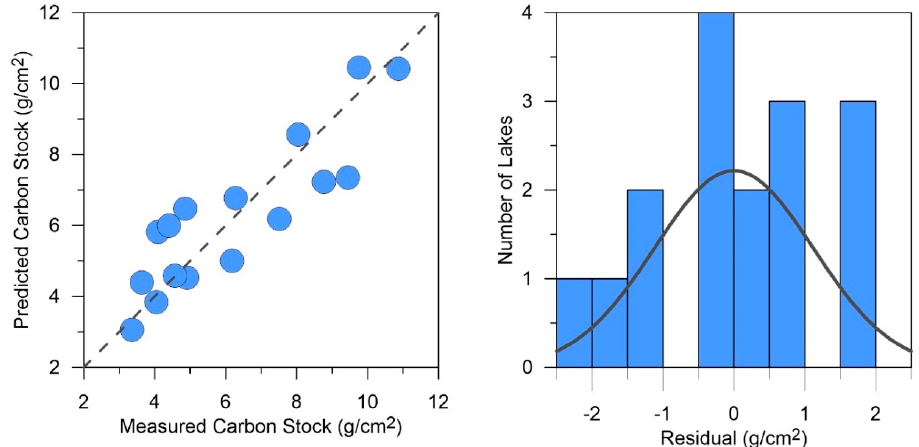
Figure 7. Results of predicting carbon stock with the multilinear regression (Table 3). Table 3. Multilinear Regression Summary.